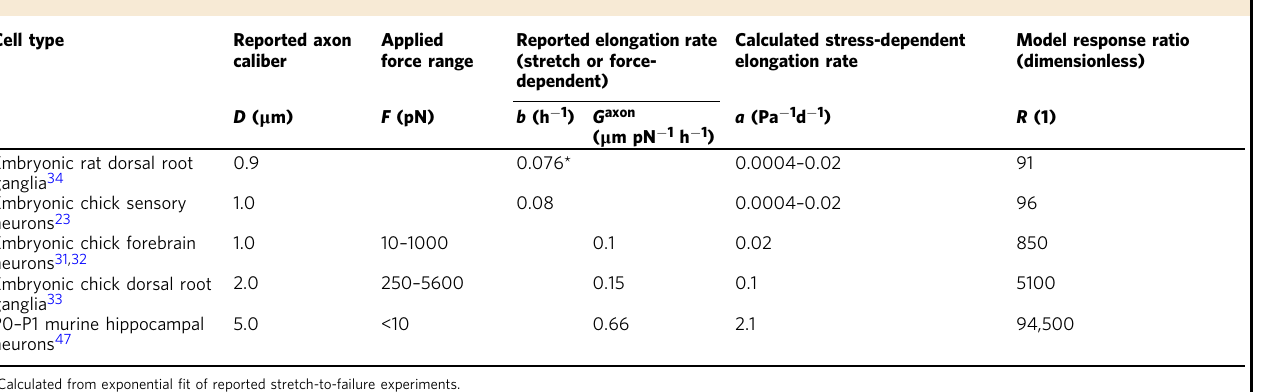
Table 1 Parameter range for neurite elongation based on available